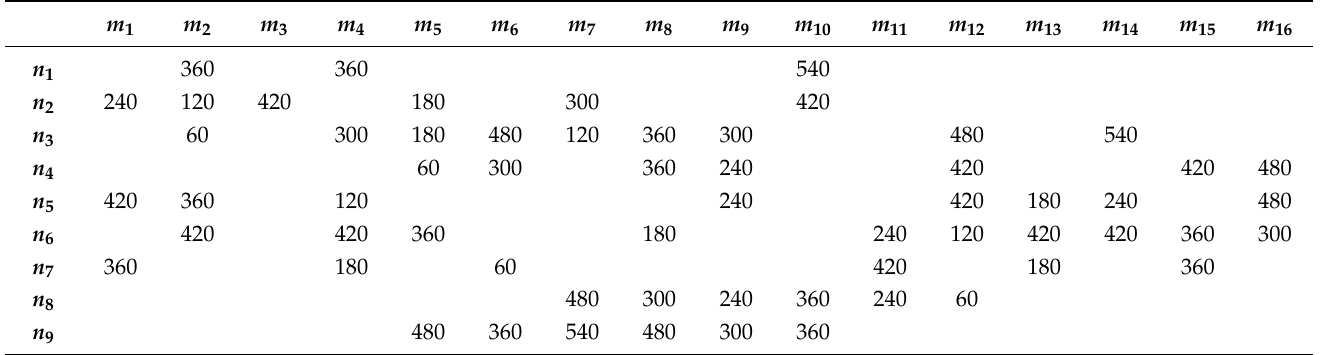
Table 14. Distance travelled for Variant #2 (km).